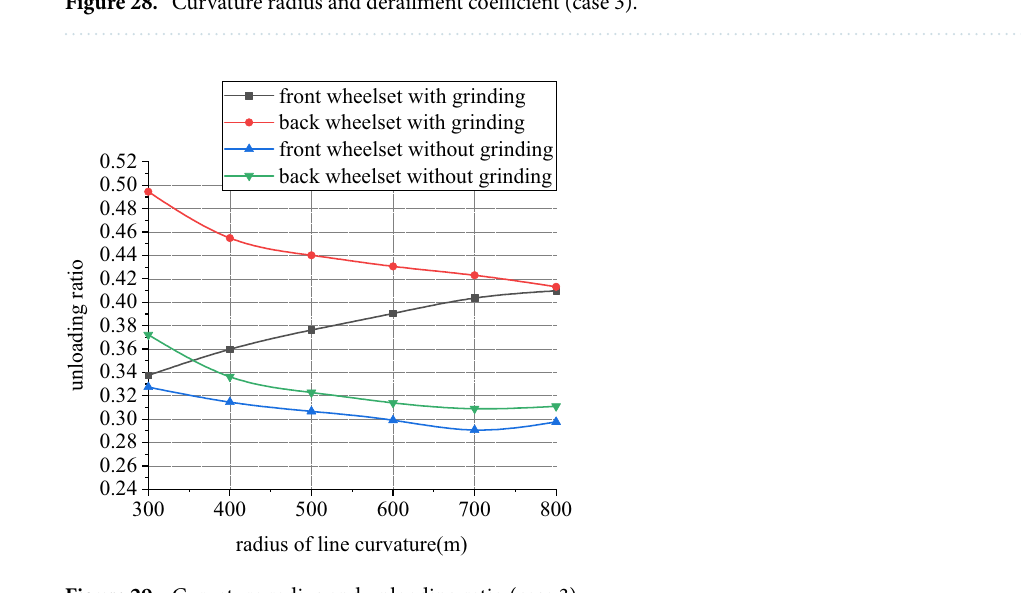
Figure 29. Curvature radius and unloading ratio (case 3).